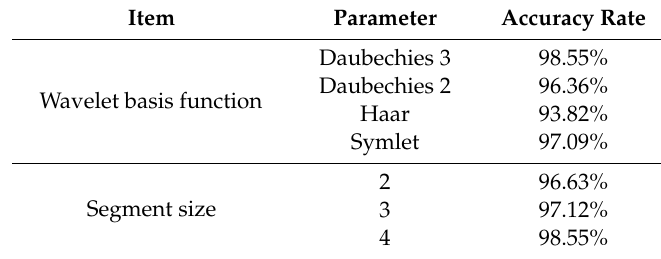
Table 4. Comparisons with di ff erent parameter of